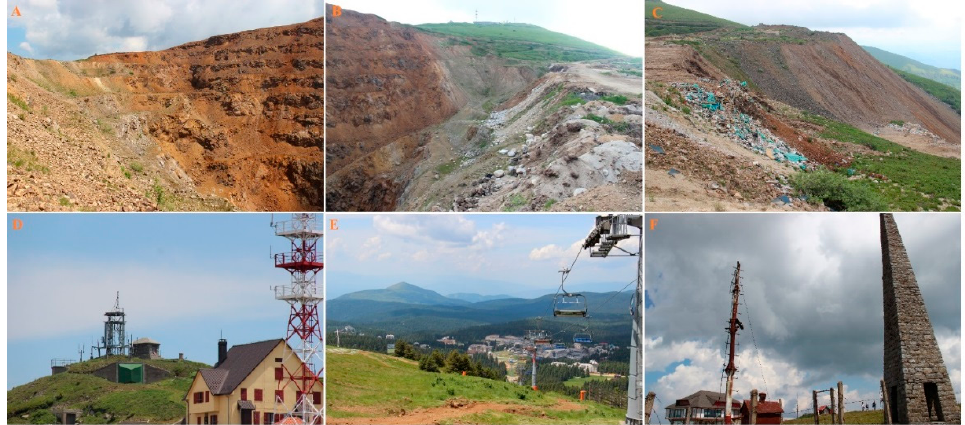
Figure 5. ( A , B ) Surface excavation at an ore field “Suvo Rudište”; ( C ) tailings at an ore field; ( D ) Pan č i ć Peak; ( E ) view from the ore field to the tourist center “Kopaonik”; ( F ) pyramid (1976 m).